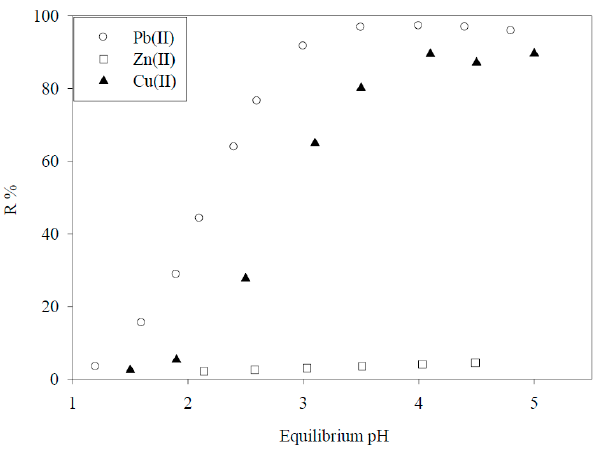
Figure 6. Adsorption of Pb(II), Zn(II), and Cu(II) by crosslinked pectic acid as a function of the equilibrium pH [9]. (With permission for reuse from Elsevier B.V.).